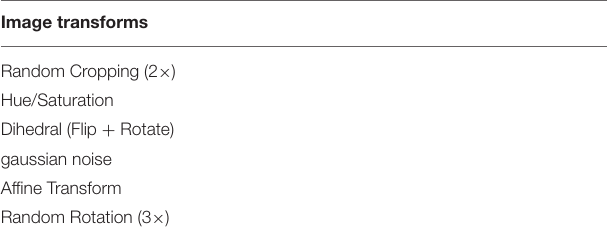
TABLE 1 | List of image transforms used for data